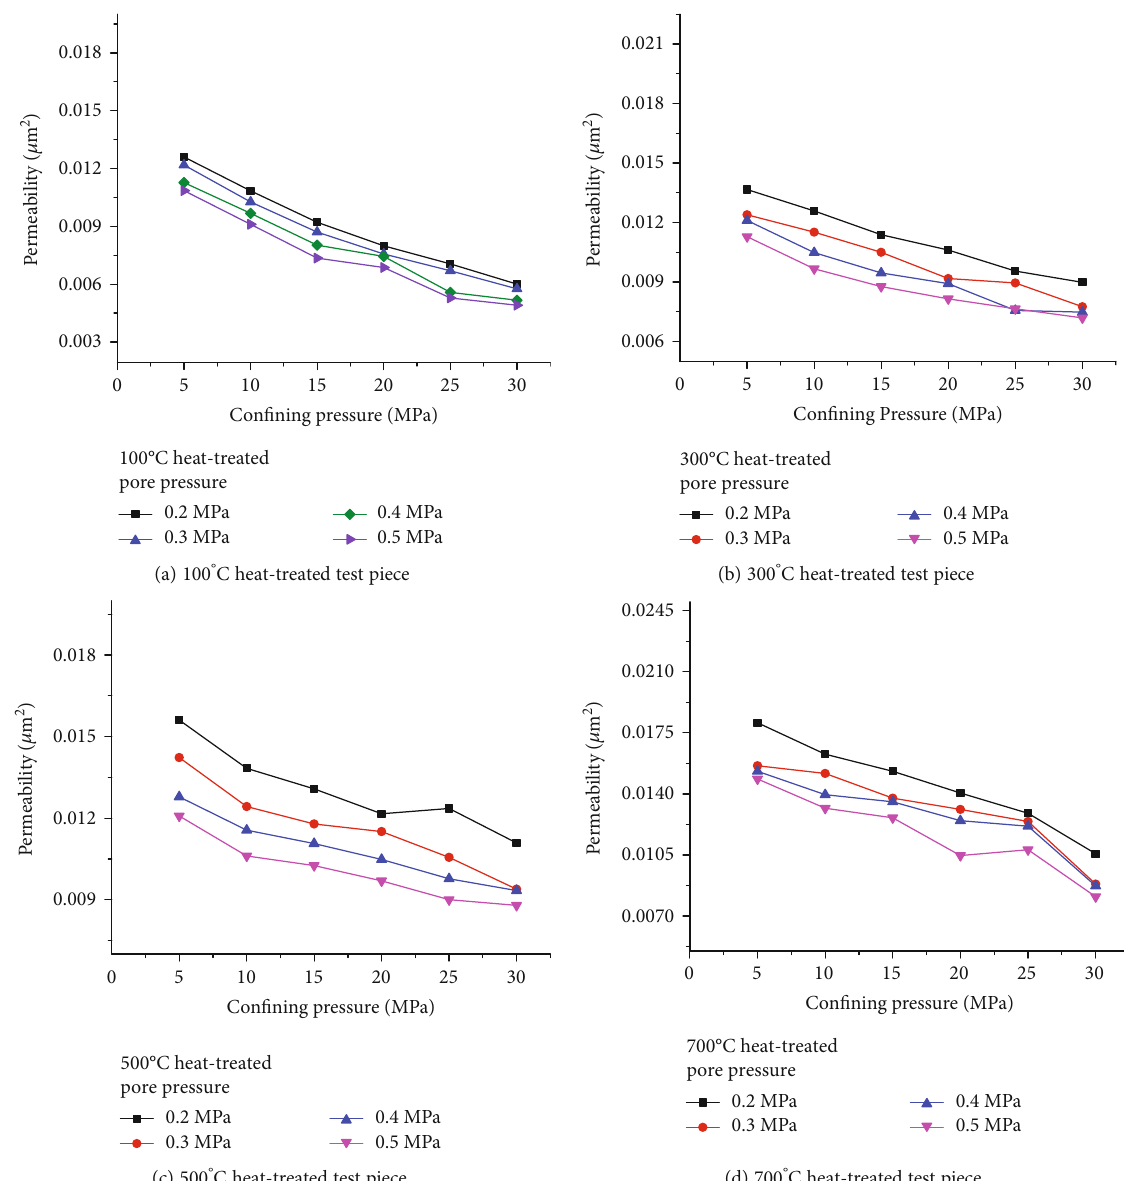
Figure 4: Permeability changes under the di ff erent con fi ning pressure